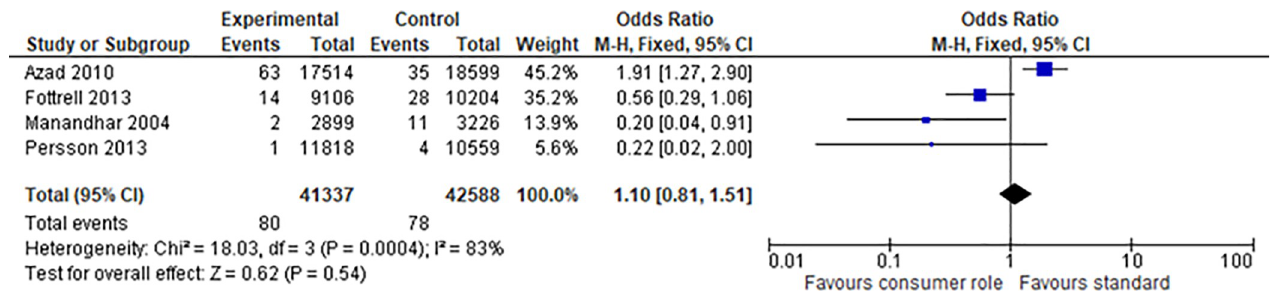
Fig 4. Meta-analysis of consumer engagement interventions for the outcome of maternal